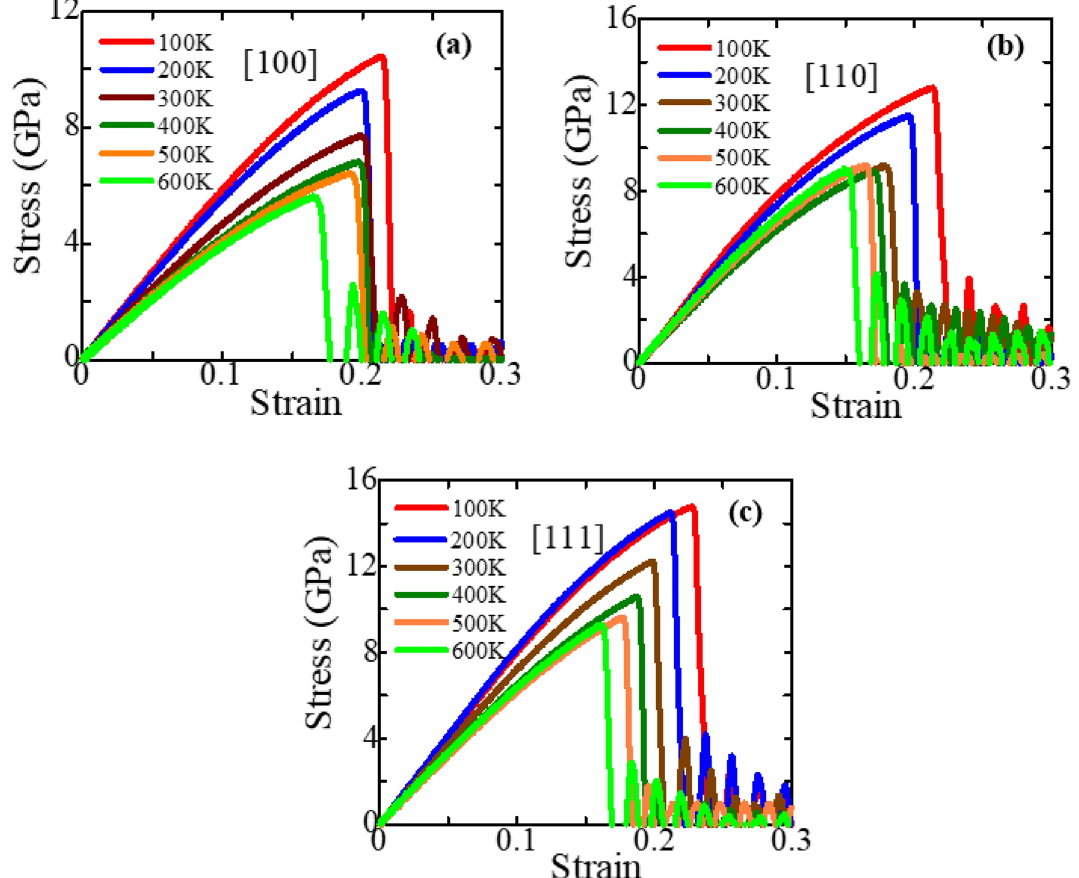
Figure 4. Stress–strain response of ( a ) [100], ( b ) [110], and ( c ) [111]-oriented 15.76 nm 2 zinc-blende ZnSe NWs at different